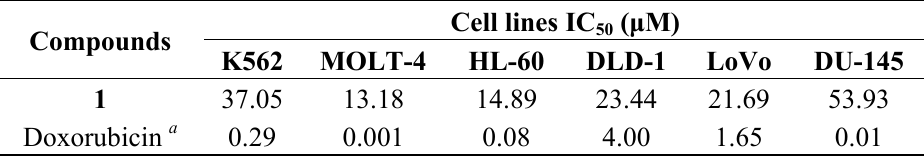
Table 2. Cytotoxic activity of diterpenoid 1